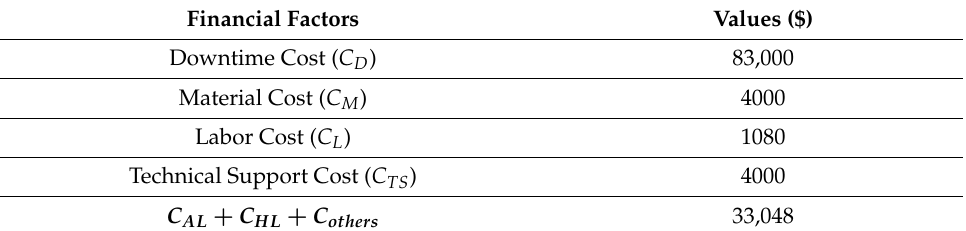
Figure 10. Contribution map by the SAE model from 22 June 2013 to 6 July 2013. Table 4. Financial factors and their values updated by bearing-related fault in the pump.